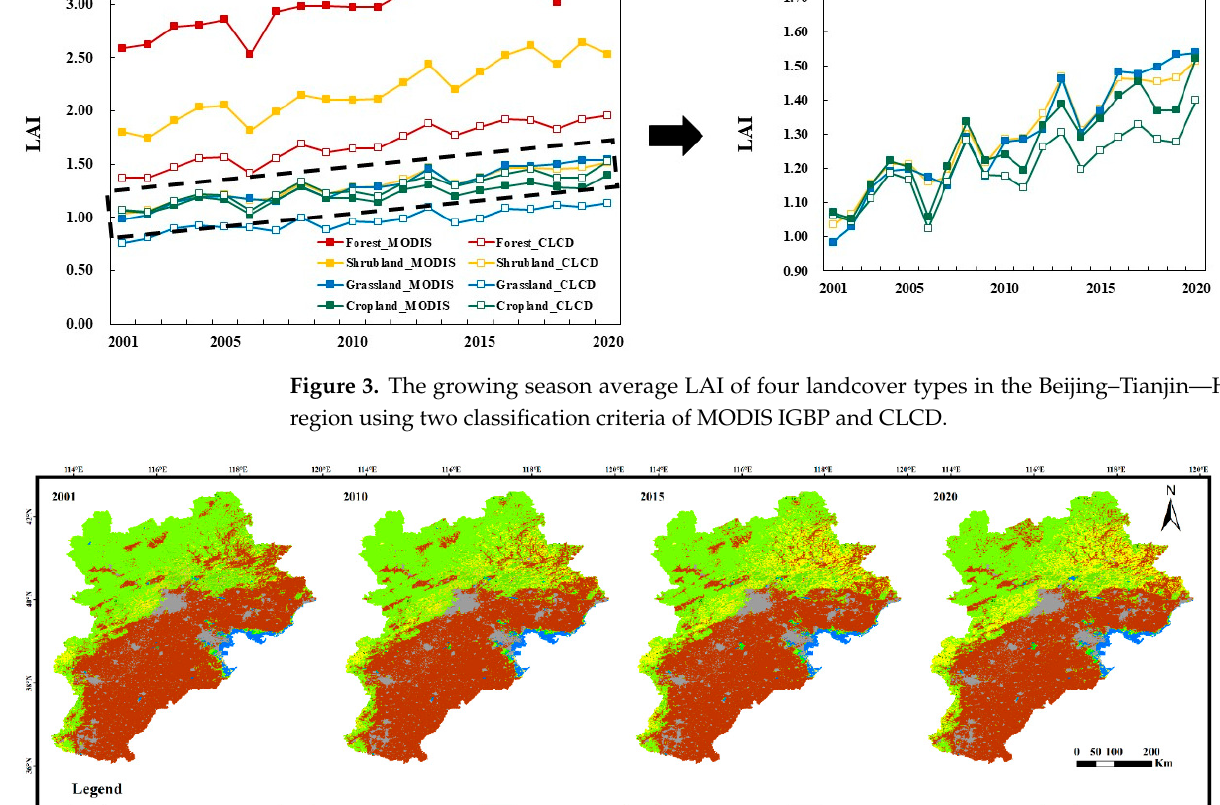
Figure 3. The growing season average LAI of four landcover types in the Beijing–Tianjin-–Hebei region using two classification criteria of MODIS IGBP and CLCD.